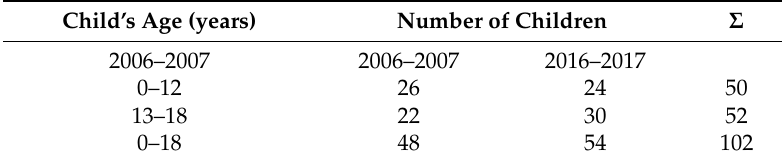
(Table 1). The frequency and reason for non-adherence to GFD was compared between children treated now (54 children) and 10 years before (48 children). Table 1. Number of children covered by the study in 2006–2007 and in 2016–2017. Child’s Age (years) Number of Children